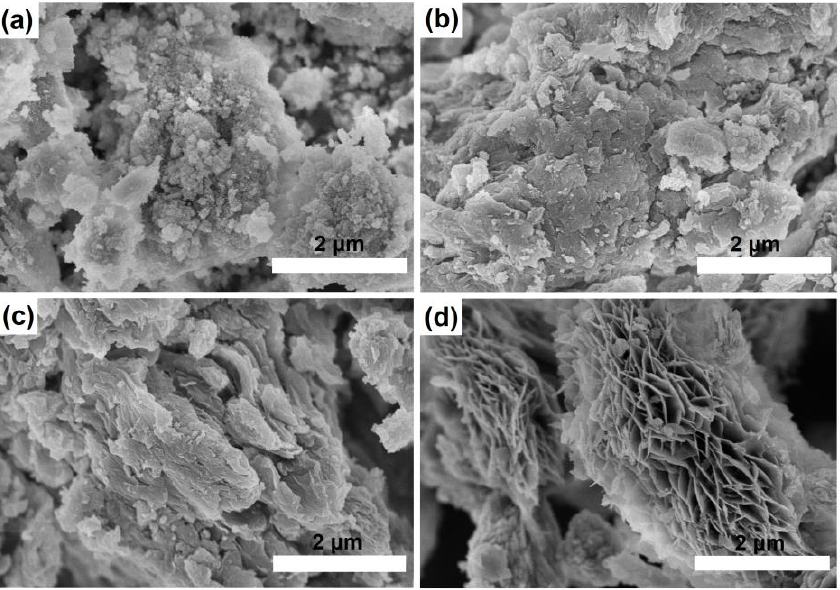
Figure 3. SEM images of intermediate phases: ( a ) Sample IF-iAl-90; ( b ) Sample IF-iAl-130; ( c ) Sample IF-SB-90; ( d ) Sample IF-SB-130.